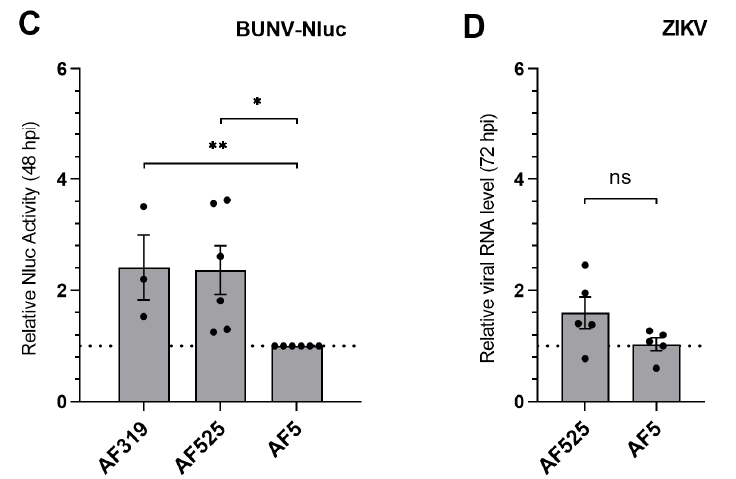
Figure 6. Viral replication in Ago2 and Dcr2 knockout cells, as well as in AF525 cells transfected